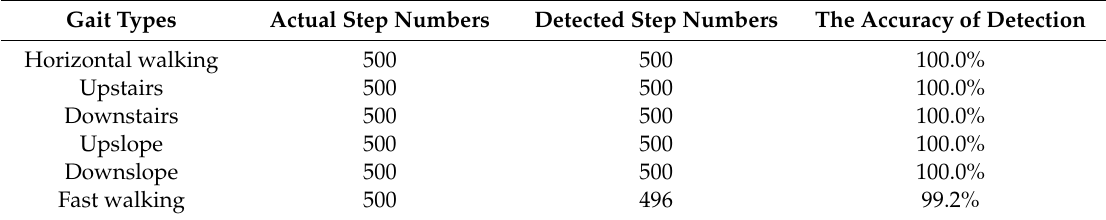
Table 2. The comparison results of zero-velocity interval detection